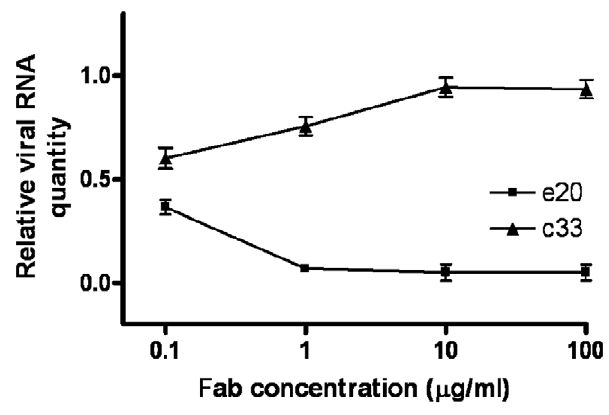
Figure 4. Neutralizing activity of Fab e20 using the HCVcc system (genotype 2a). The infectivity of JFH-1 in the presence of e20 and of negative-control Fab (c33-3) is presented as the viral RNA quantity normalized against glyceraldehyde-3-phosphate dehydroge- nase RNA, as determined by quantitative reverse transcription-PCR [32]. The means and standard errors of three replicate assays are reported. doi:10.1371/journal.pone.0008254.g004 conserved nature of its epitope. The wide cross-reactivity of Fab e20 was also documented by immunoprecipitation of HCV/E2 on radiolabeled lysates from HEK293T cells expressing HCV surface proteins of different genotypes (data not shown). The